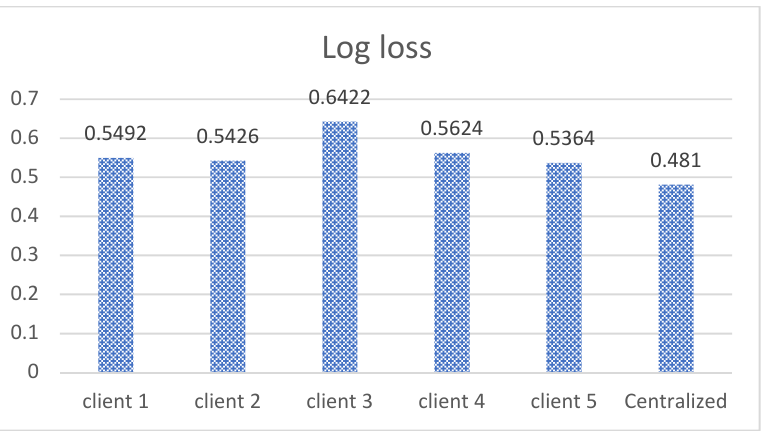
Figure 5. Comparison of log loss between different clients and centralized model.